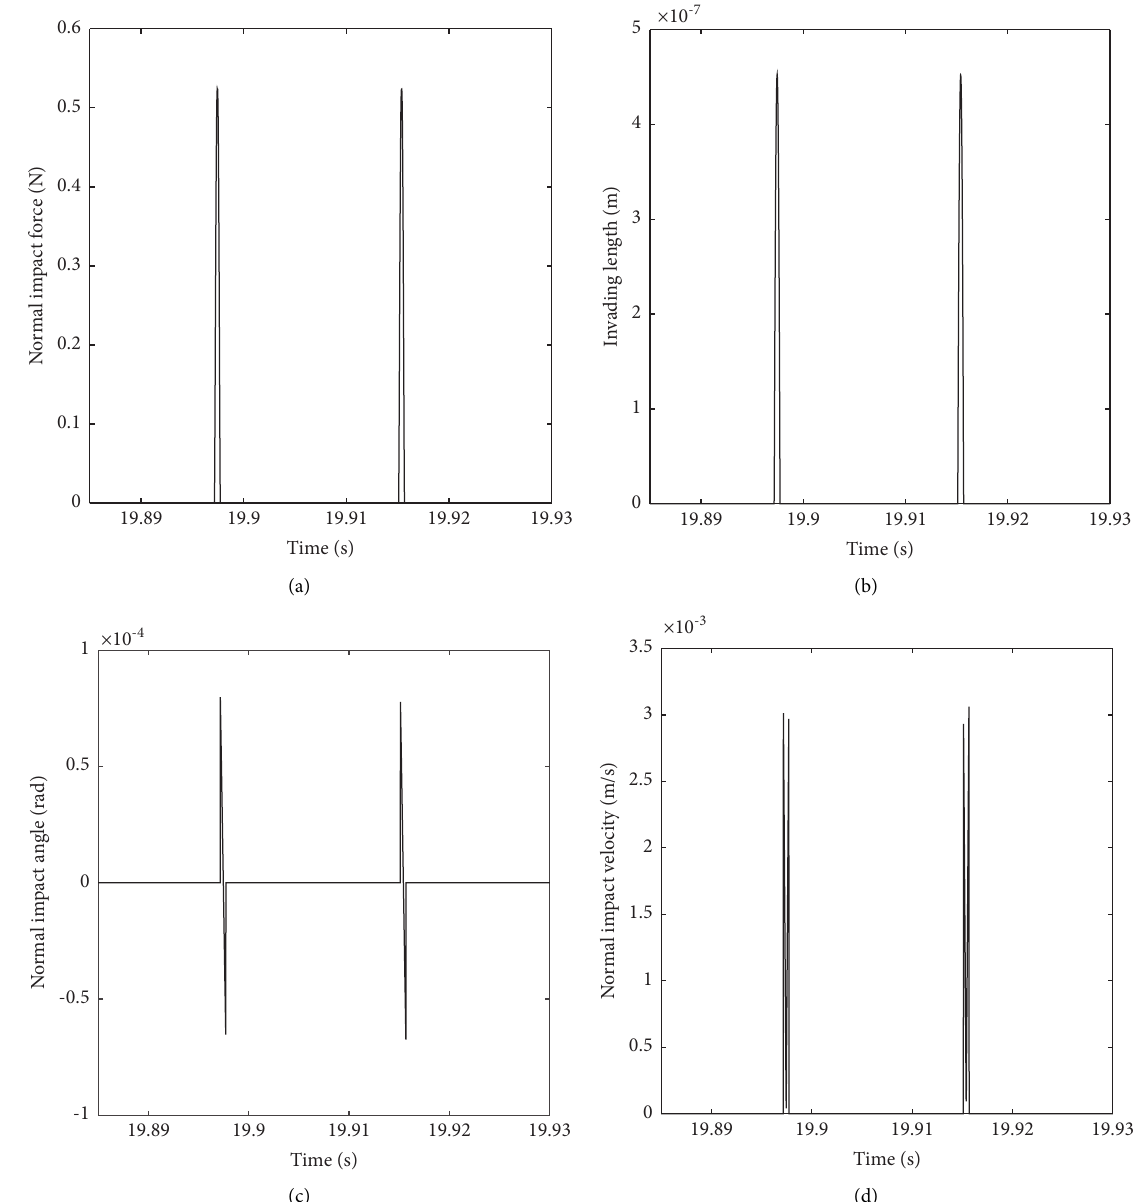
Figure 14: Rubbing process of the MSDS with K angle. (d) Normal impact Figure 15 provides the waterfall plots of the outer rotor response for both no rubbing and rubbing with K � 2 and r � 1.5. Under the condition of no rubbing, in K d s contrast to the dynamic responses with r difference is that the first appearance of frequency com- ponent f /2 is at a lower rotational speed when r c 2 may be mainly caused by the sharp increase in the un- balanced force provided by the outer rotor with higher speed ratio. Because the outer rotor speed increases with the speed ratio when the inner rotor speed keeps constant, and the unbalanced force is proportional to the square of the speed, when the rubbing occurs, due to the existence of